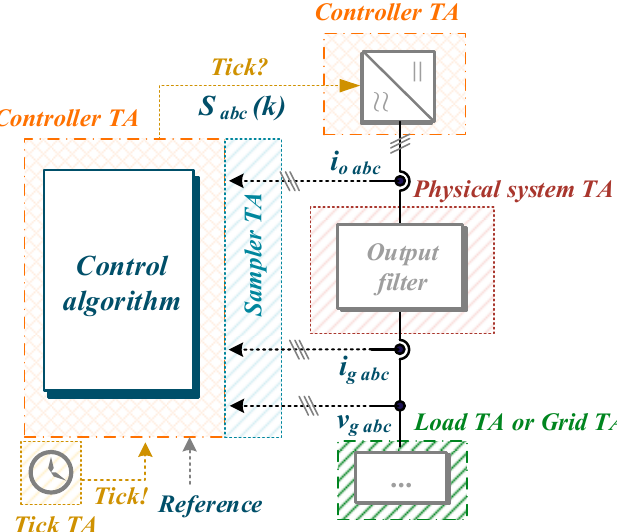
Figure 8. Modeling a power electronics converter system in UPPAAL.